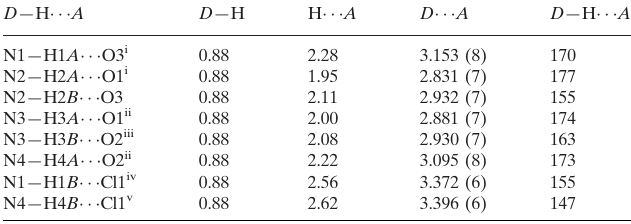
Hydrogen-bond geometry (A˚ , (cid:4) ). D —H (cid:3)(cid:3)(cid:3) A D